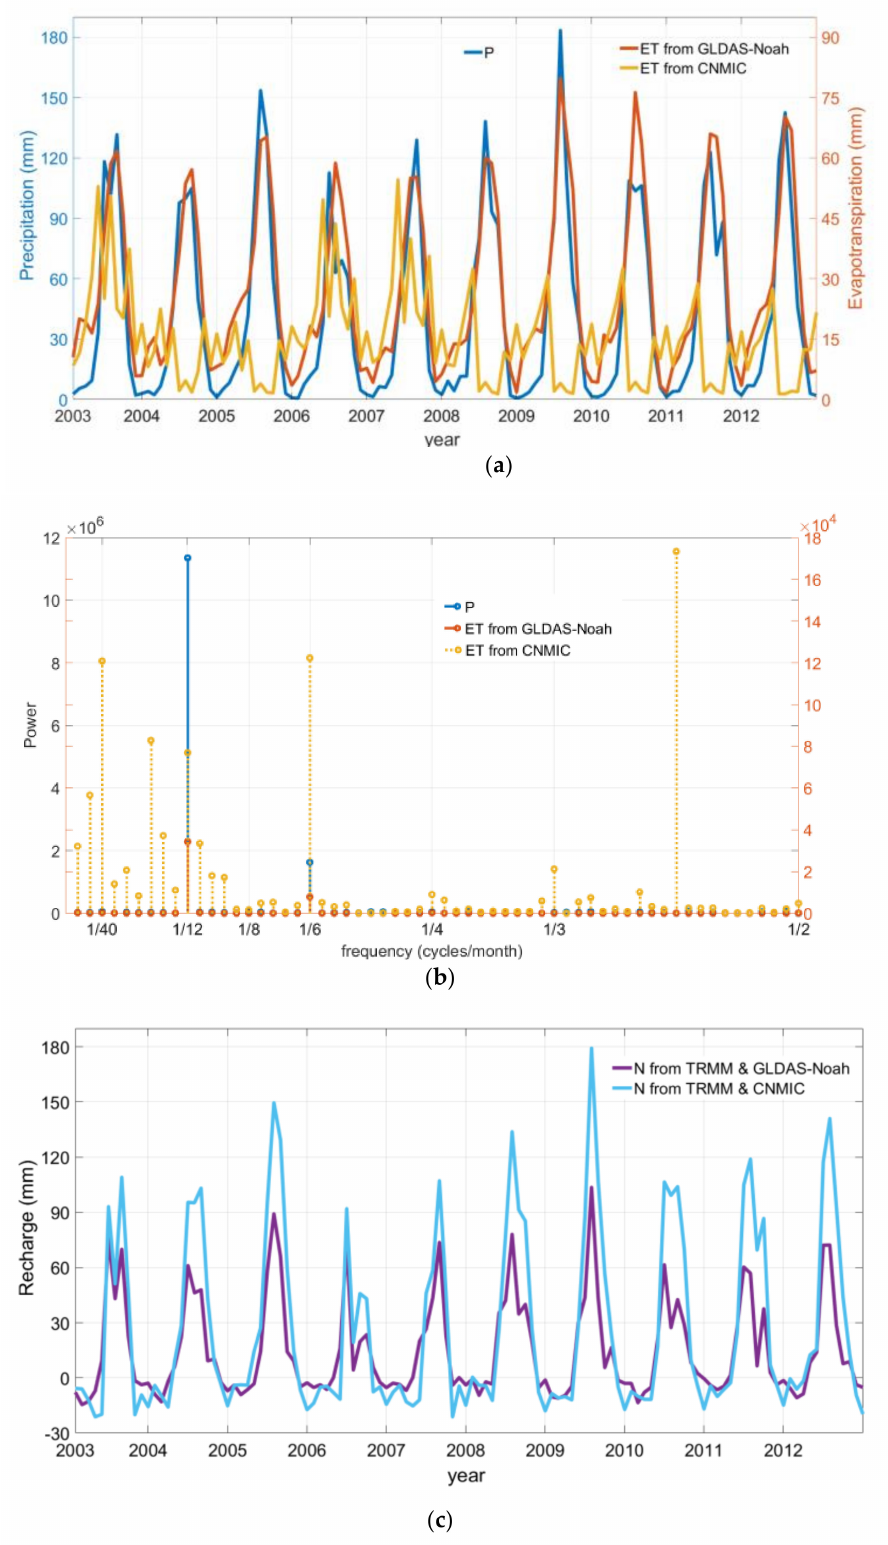
Figure 4. ( a ) TRMM Precipitation and evapotranspiration (from GLDAS-Noah and CNMIC) time series in Yangtze River Source Region from 2003 to 2012; ( b ) Power spectrum of precipitation and evapotranspiration time series in the study region, and ( c ) The recharge of the catchment calculated from the data